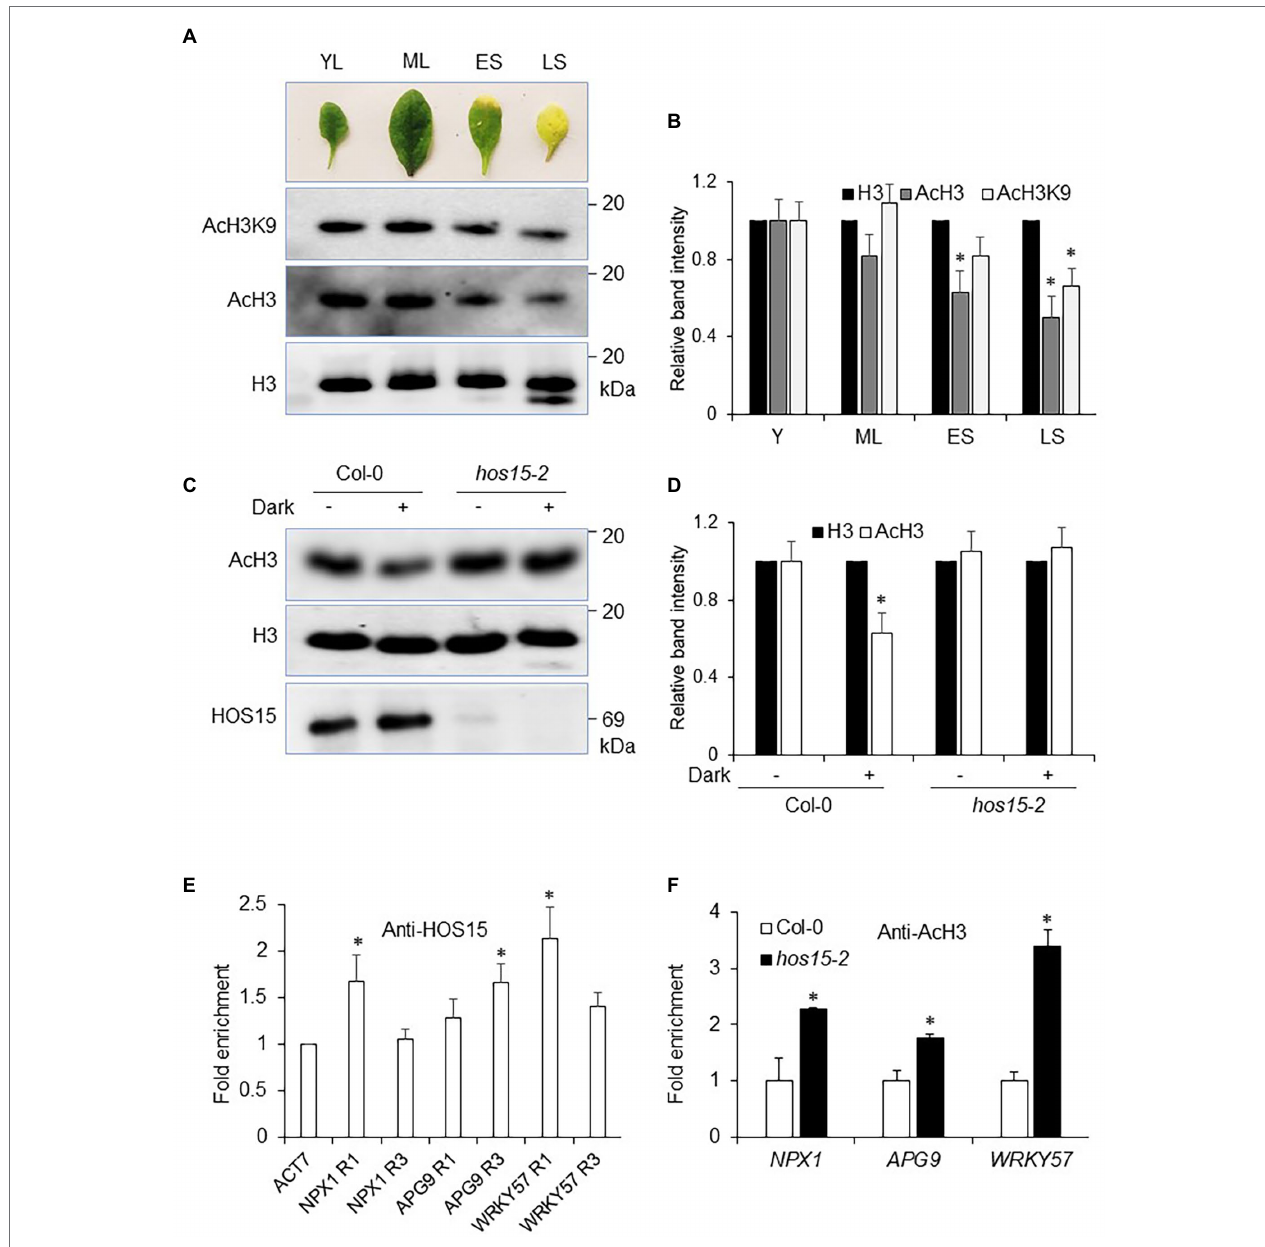
FIGURE 6 | HOS15 represses H3 acetylation status during senescence. (A) Plant senescence/aging negatively regulates histone acetylation status. Same age leaves were sampled for nuclear protein extraction. Anti-H3, AcH3, and AcH3K9 antibodies were used to detect the acetylation level in leaves in an age-dependent manner (YL = young leaves, ML = mature leaves, ES = early senescence, and LS = late senescence leaves; previously described by Sun et al., 2017). (B) Relative band intensity of H3, AcH3, and AcH3K9 in (A), quantified by ImageJ software, with signal level of H3 set to 1. Error bars represent SE. Significant differences were determined via Student’s t -test (significance: * p < .05). (C) HOS15 regulates dark-induced senescence by affecting H3 acetylation status. Twelve-day-old seedlings of Col-0 and hos15-2 plants were treated with 4 days of darkness, and then, nuclear proteins were extracted. H3, AcH3 and HOS15 antibodies were used for WB. H3 was used as the loading control. (D) Relative band intensity of H3 and AcH3 in (C) , quantified by ImageJ software, with signal level of H3 set to 1. Error bars represent SE. Significant differences were determined via Student’s t -test (significance: * p < .05). (E) ChIP assay was performed with anti-HOS15 antibody in Col-0 (WT) plants. hos15-2 plants were used as negative control. The amount of DNA in the immunoprecipitated complex was determined by RT-qPCR and is presented as the fold enrichment after normalization with control using the ACTIN7 gene promoter. Data represent means (SD) from three biological replicates with three technical repeats. Significant differences were determined via Student’s t -test (significance: * p < .05). Specific loci used for ChIP assay are described in Supplementary Figure 4 . (F) Chip-qRT-PCR for the leaf senescence negative regulator genes; NPX1, APG9 , and WRKY57. H3 acetylation status were increased in hos15-2 as compared to Col-0 plants. ACTIN2 was used as the normalization control. Error bars represent SD of three biological repeats. Significant differences were determined via Student’s t -test (significance: * p <